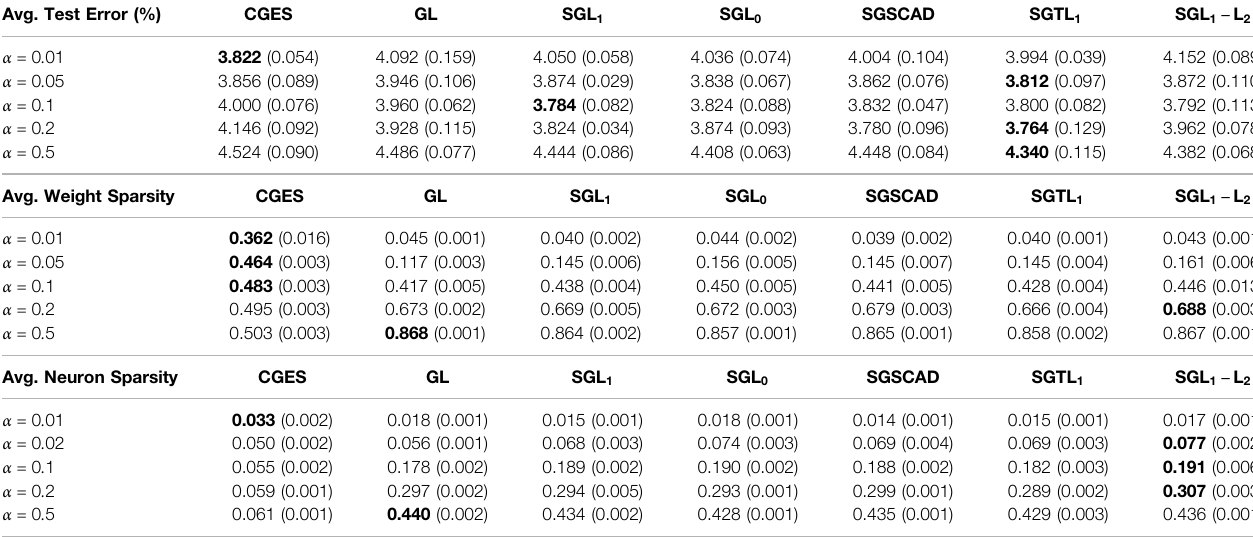
TABLE8| Averagetesterror,weightsparsity,andneuronsparsityofWRN-28-10modelstrainedonCIFAR10withlowesttesterrorsacross5runs.Standarddeviationsare in parentheses. Avg. Test Error (%)